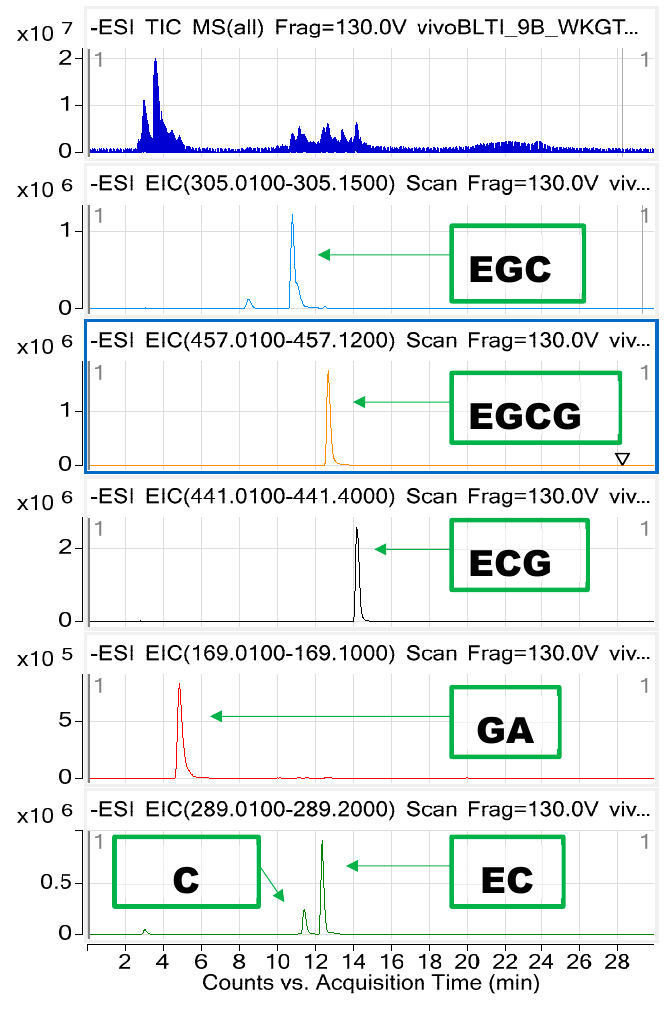
Figure 3. The EIC chromatograms of all catechins identified in the extracts in the negative mode of LC ESI-Q-TOF-MS analysis, identified based on the comparison with reference compounds.